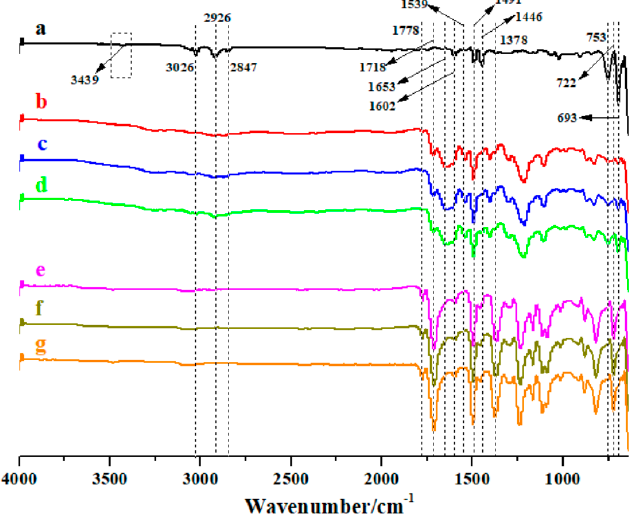
Figure 1. FTIR spectra of the synthesized polymers: ( a ), amino endcapped PS; ( b ), PAA I - b -PS; ( c ), PAA II - b -PS; ( d ), PAAI II - b -PS; ( e – g ), porous PI films from ( b – d ) by thermal treatment.